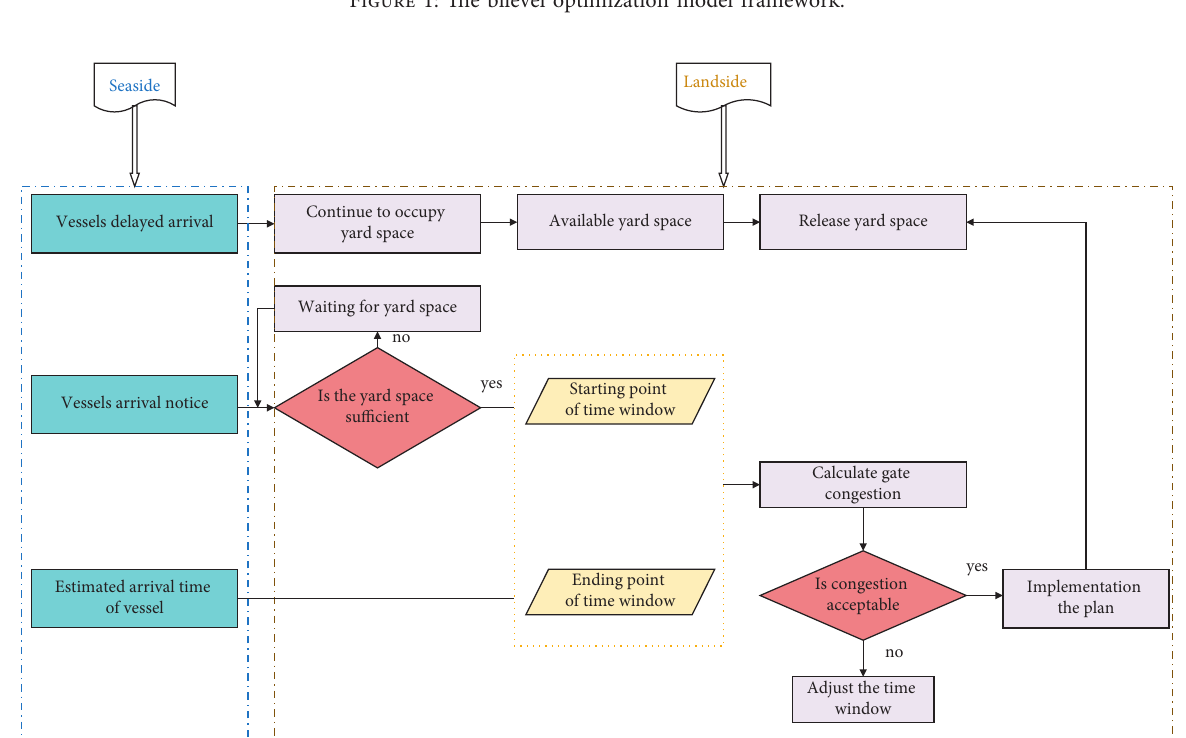
Figure 2: The details of the upper-level